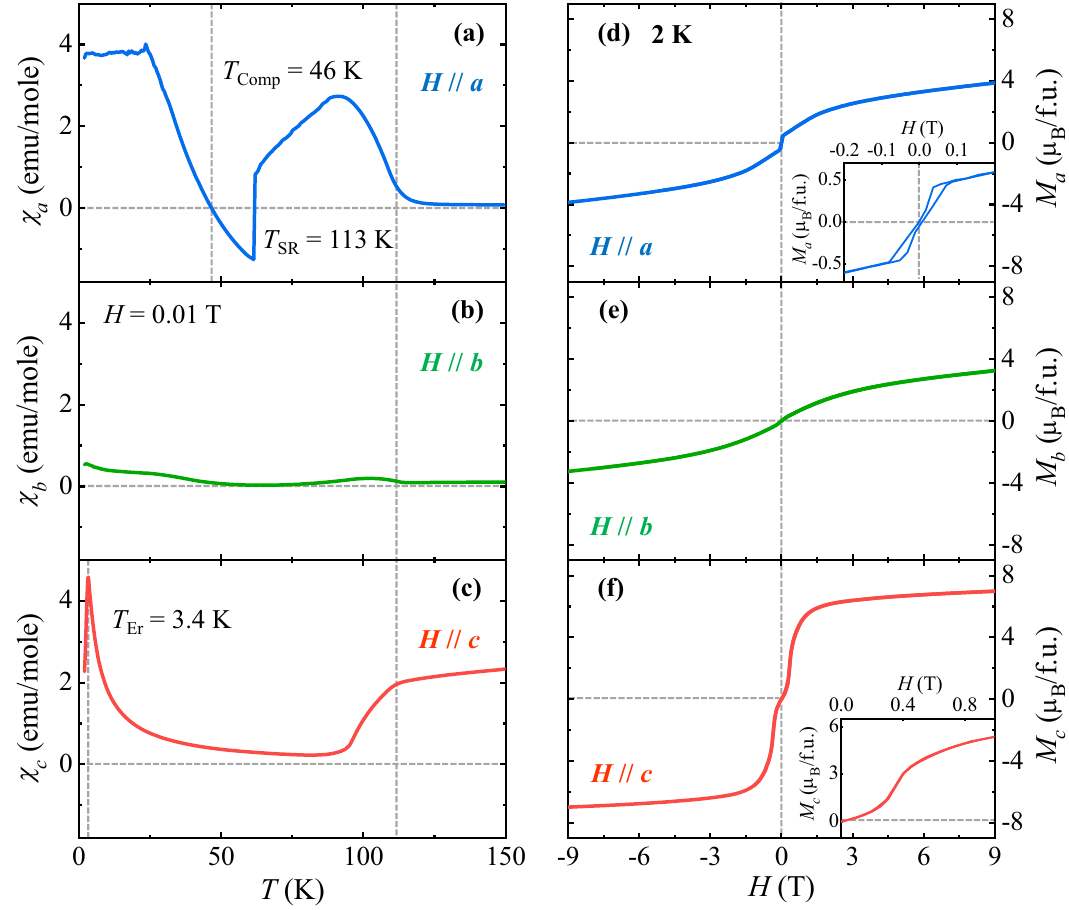
Figure 2. Temperature- and magnetic-field-dependent magnetic properties of ErFeO 3 . ( a )–( c ) Temperature dependence of magnetic susceptibility, χ = M / H , shown for the EFO crystal for H = 0.01 T upon warming after zero-magnetic-field cooling along the a , b , and c axes, respectively. The vertical dotted lines indicate the spin- reorientation temperature ( T SR = 113 K), compensation temperature ( T comp = 46 K), and ordering temperature of Er 3+ moments ( T Er = 3.4 K). ( d )–( f ) Isothermal magnetization of the EFO crystal in H // a ( d ), H // b ( e ), and H // c ( f ), measured at T = 2 K up to 9 T. The inset of ( d ) shows the magnified view in the range of H = ± 0.2 T of the hysteresis loop in H // a . The inset of ( f ) displays the enlarged view in the rage of H = 0–1 T in H // c